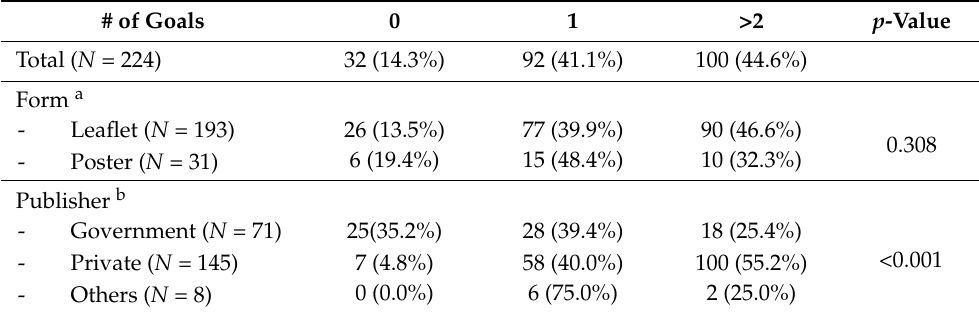
Table 2. Number of Superordinate Goals in a PA Print Material ( N = 224).